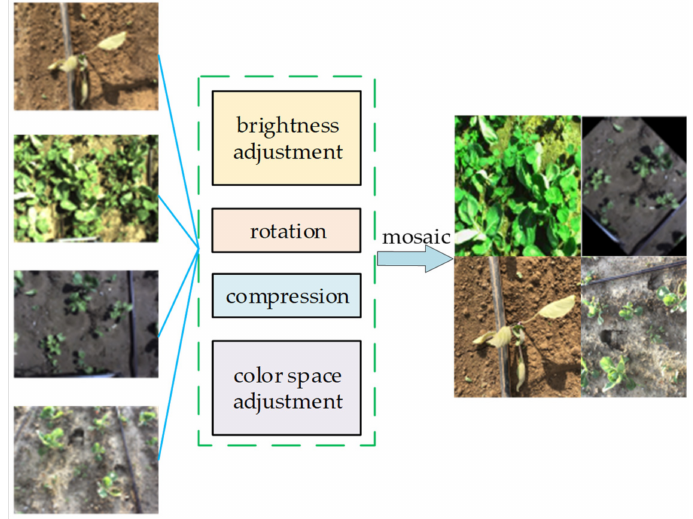
Figure 5. Mosaic data